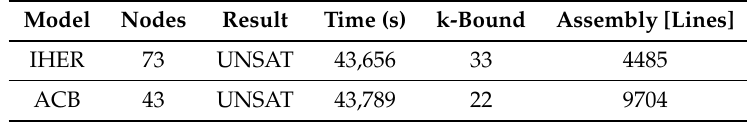
Table 4. Verification result of program